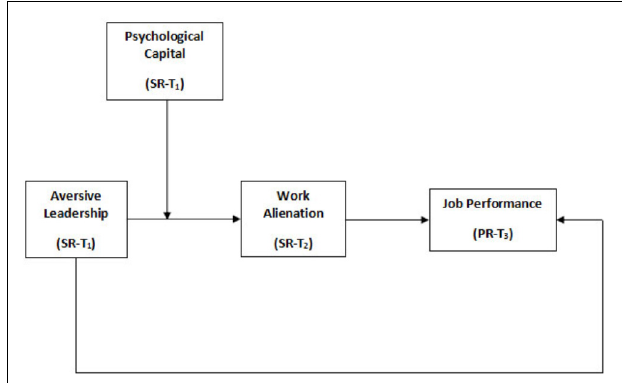
FIGURE 1 | Proposed model